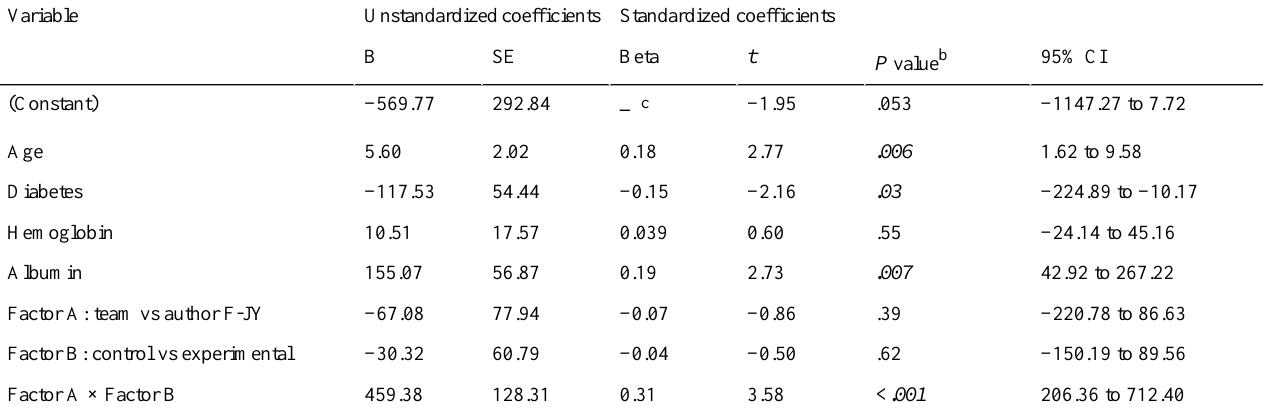
Table 4. Associations between time to dialysis and care model using difference in differences a .